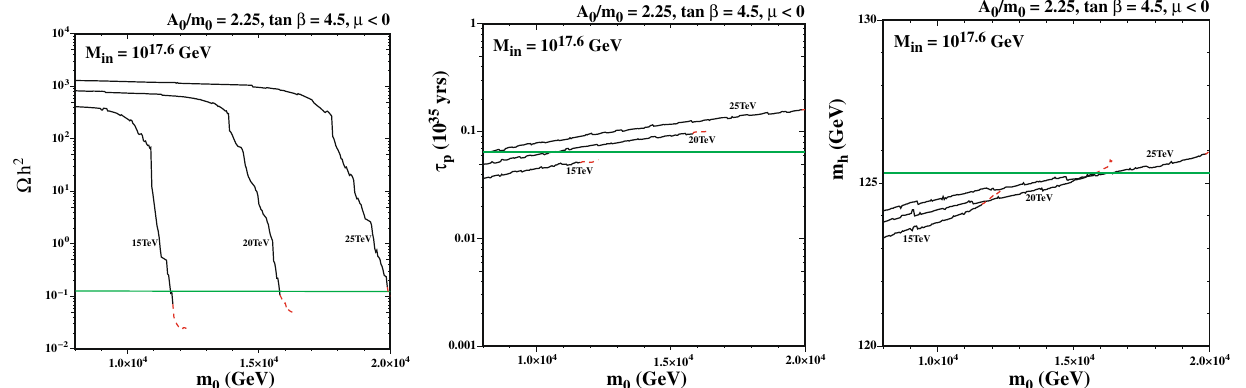
is the lighter stop and terminating when the RGE calculations break down. The horizontal green lines correspond to the cosmological value of (cid:21) LSP h 2 , the experimental lower limit on τ( p → K + ν) and the experimental value of m h , respectively